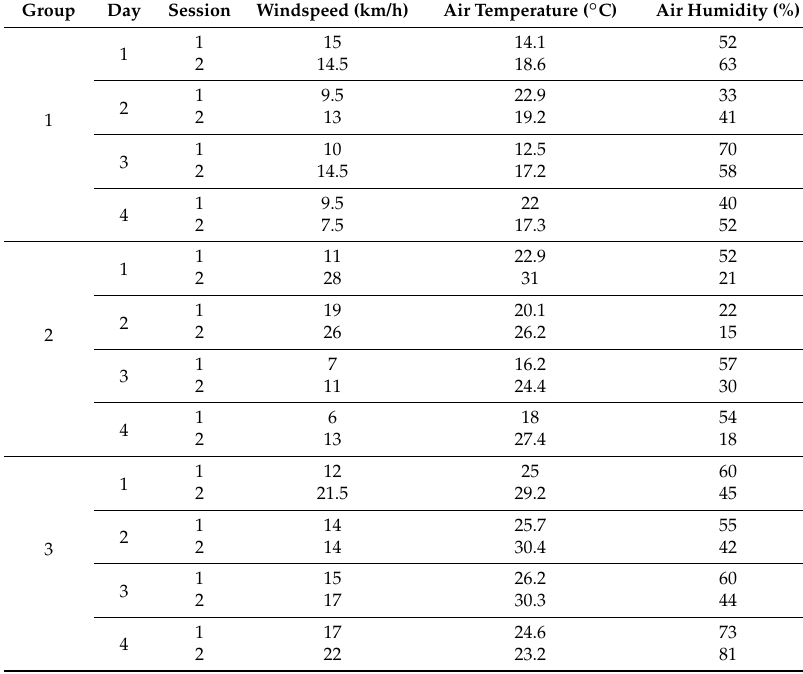
Table A1. Mean environmental conditions experienced on testing